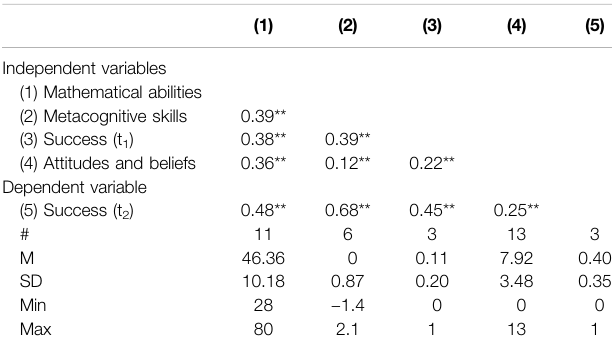
TABLE 1 | Descriptive statistics and correlations of all variables for both experimental conditions.